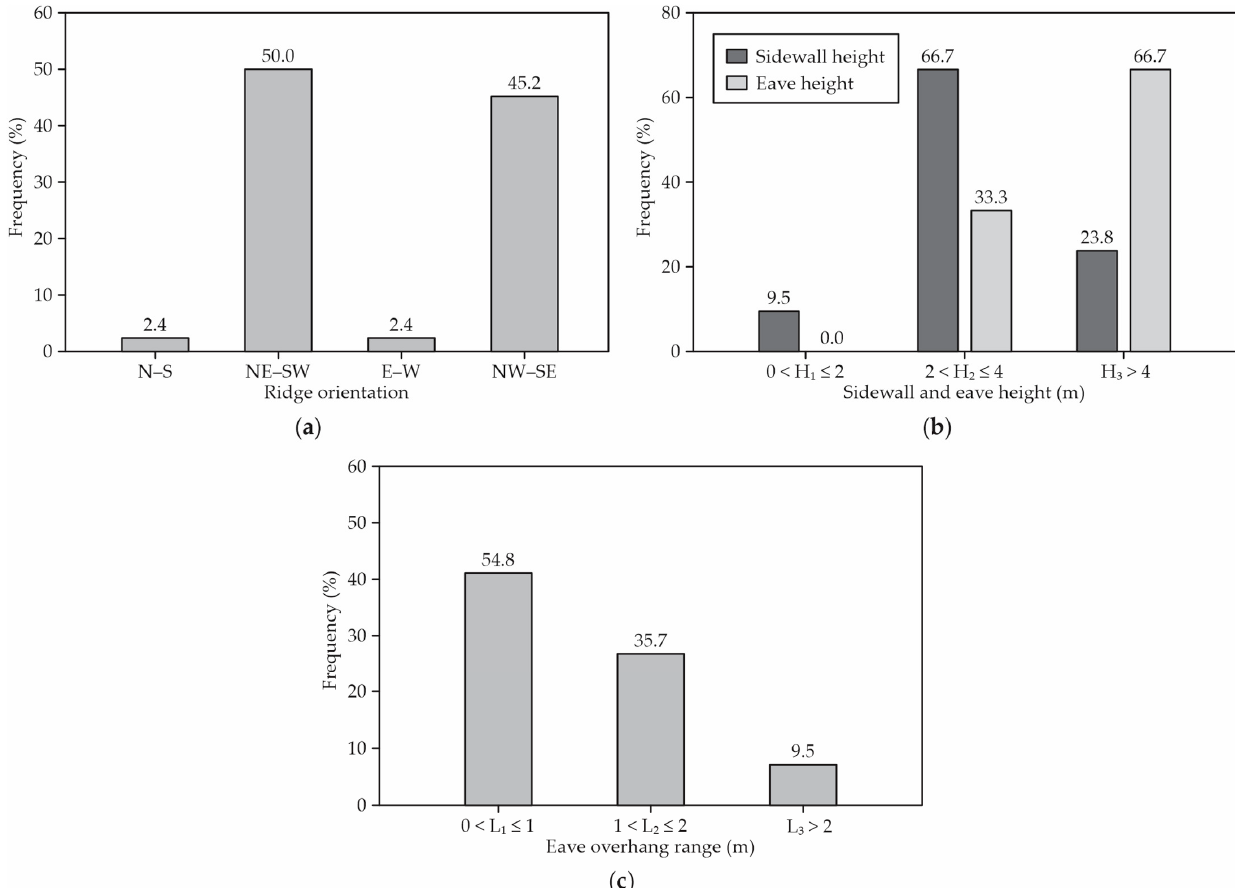
Figure 4. Frequency distribution of ( a ) ridge orientation, ( b ) sidewall and eave height, and ( c ) eave overhang range. N–S: north–south; NE–SW: northeast–southwest; E–W: east–west; and NW–SE: northwest–southeast.